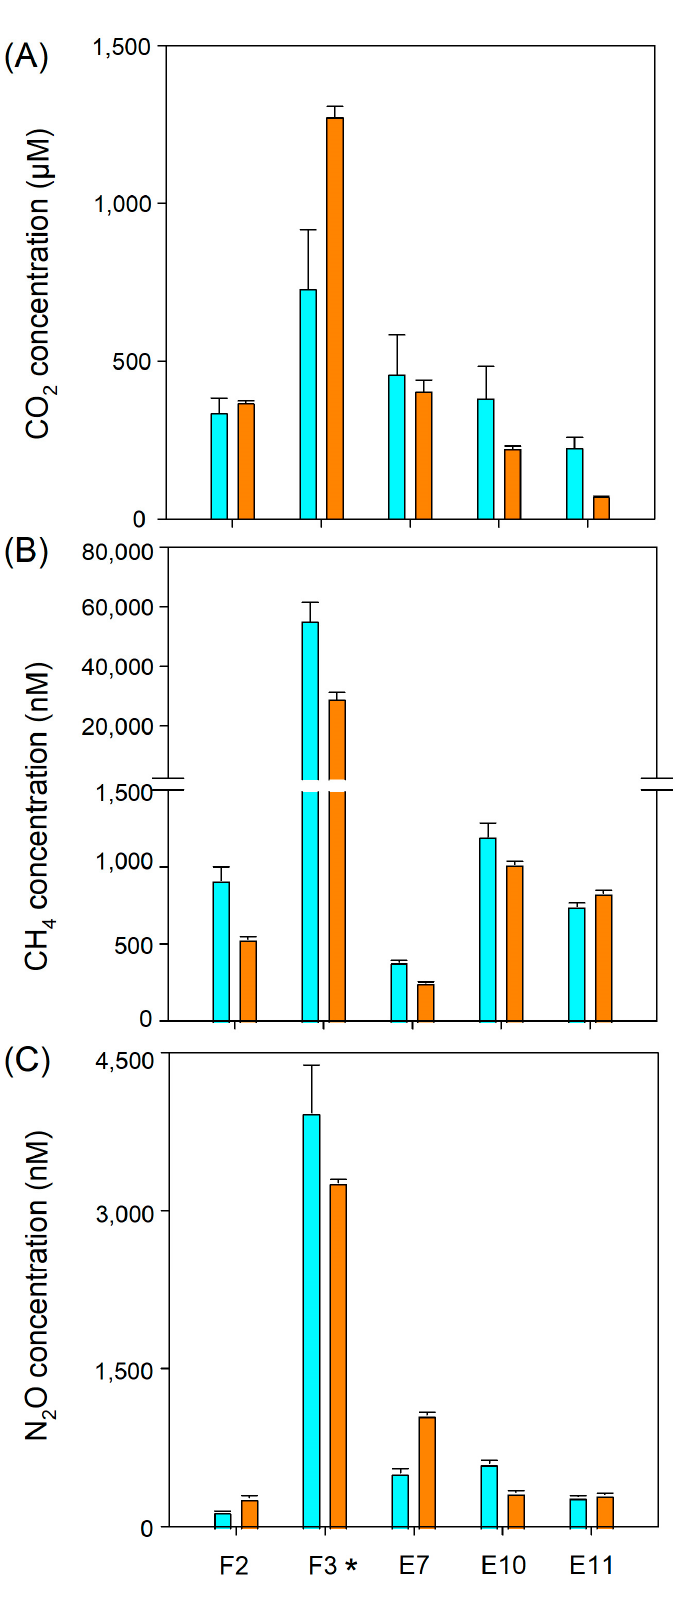
Figure 3. Greenhouse gas concentration ( A ) CO 2 , ( B ) CH 4 , and ( C ) N 2 O dissolved in water in winter (cyan bars) and summer (orange bars) of El Sauce Estuary. * Discharge